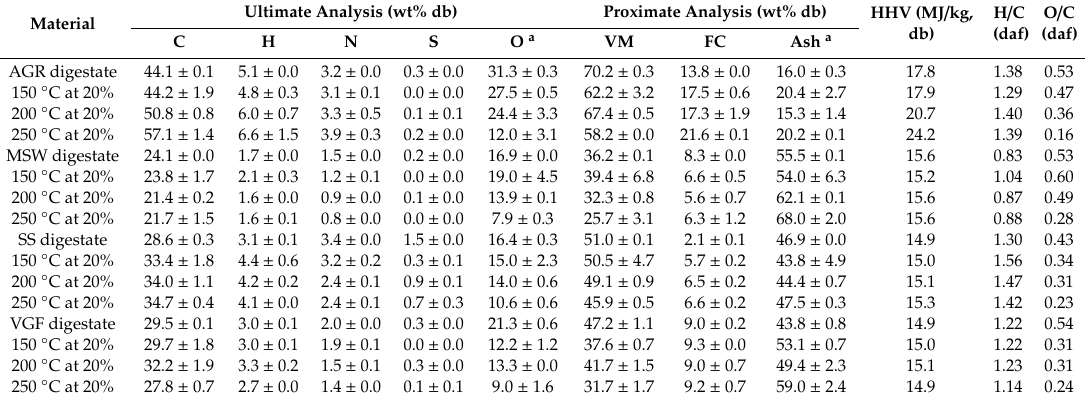
Table 3. Ultimate, proximate, and heating of analysis of feedstock and corresponding hydrochar.